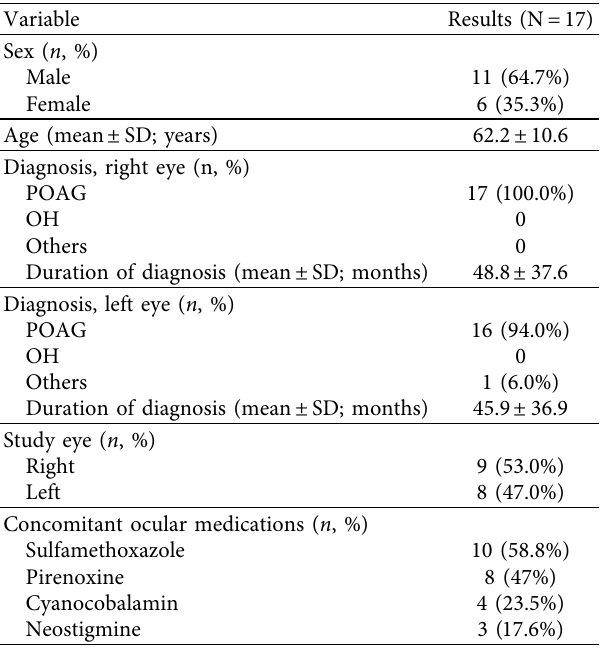
Table 2: Results of fluorescein staining scores (NEI scale) at each visit.